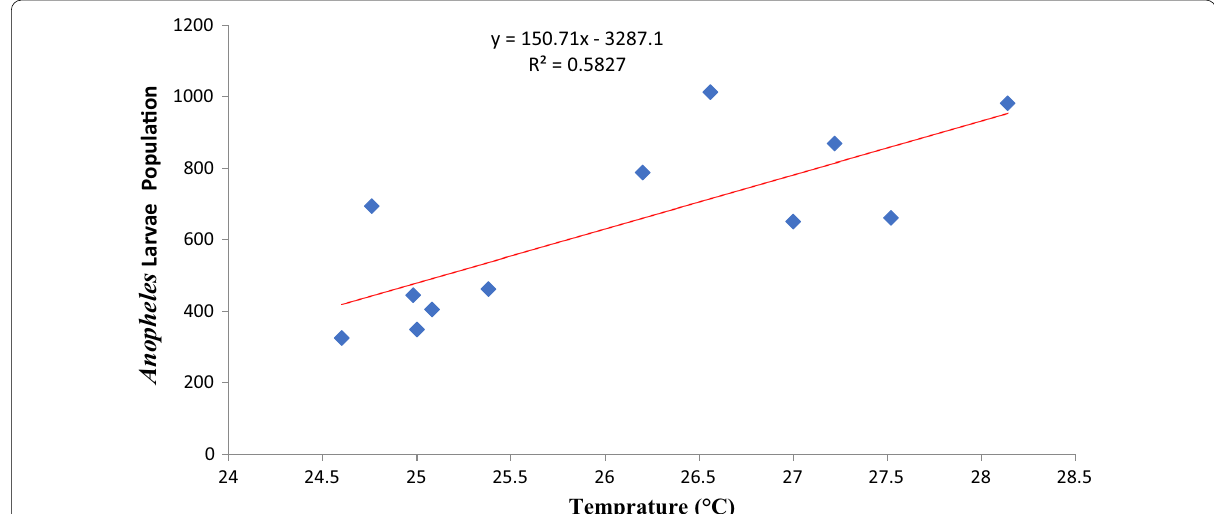
Fig. 4 Regression relationship between Anopheles larvae population and temperature values ( ℃ ) of habitats in Akure North LGA